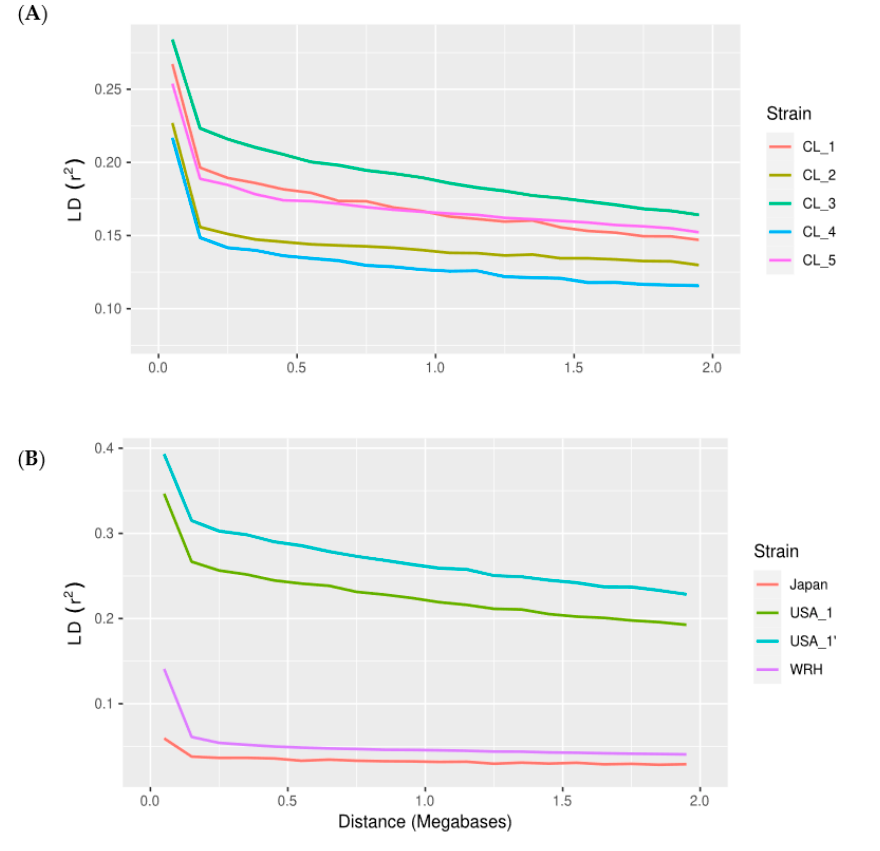
Figure 1. Decay of the average linkage disequilibrium (LD) genome-wide, measured as r 2 against physical distance (Mb): ( A ) Chilean strains, and ( B ) North American strains and Japanese